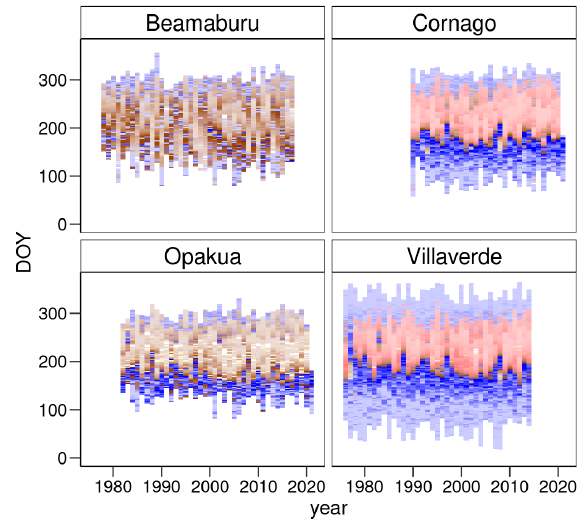
Figure 8. Climatic limitations of daily simulated partial growth rates (Gr) throughout the study periods in each site. When low temperature is the main limiting factor of growth (GrT < GrM), the colors of symbols are blue; if the main limiting factor is low soil moisture (GrT > GrM), then sym- bols are red; when soil moisture limits growth, symbols are brown; the white symbols show opti- mal climatic conditions (GrT = GrM = 1). DOY is the day of the year.